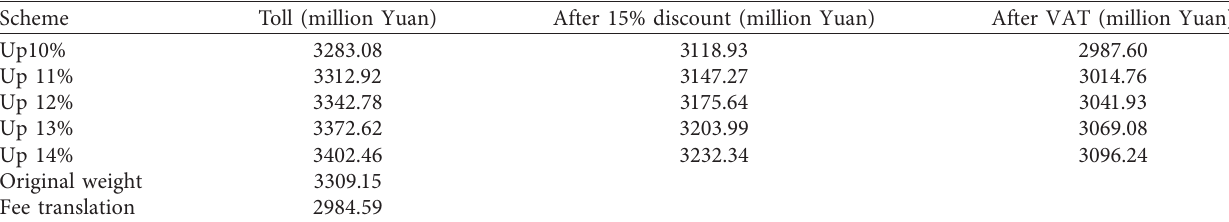
Table 10: Toll calculation table after dynamic adjustment of different rates.